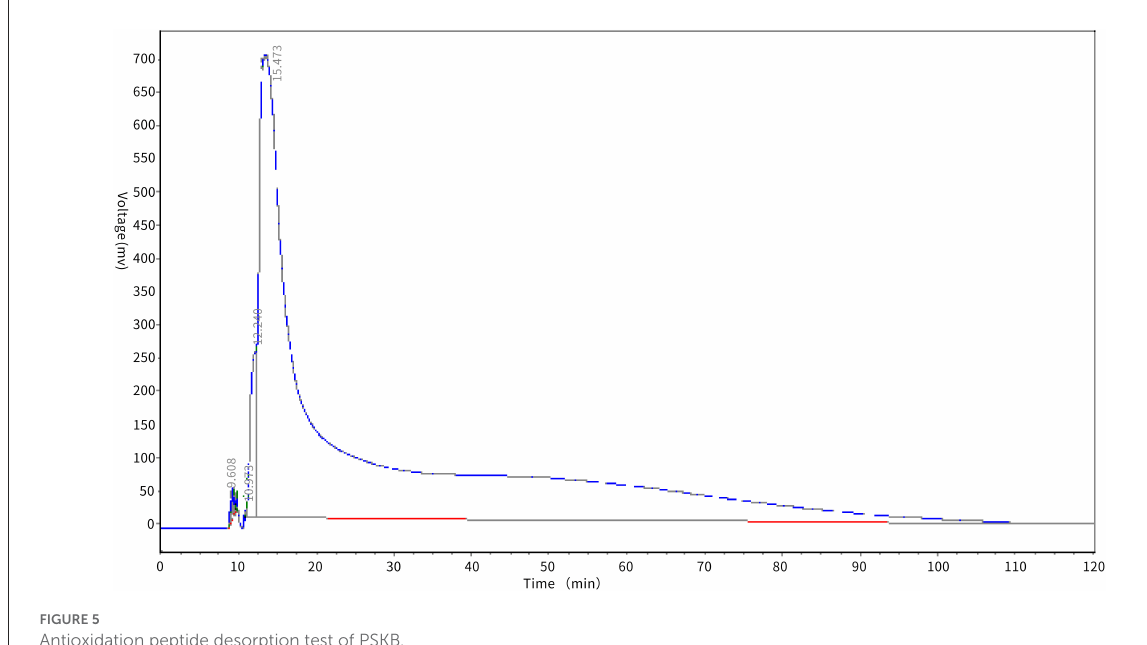
FIGURE5 Antioxidation peptide desorption test of